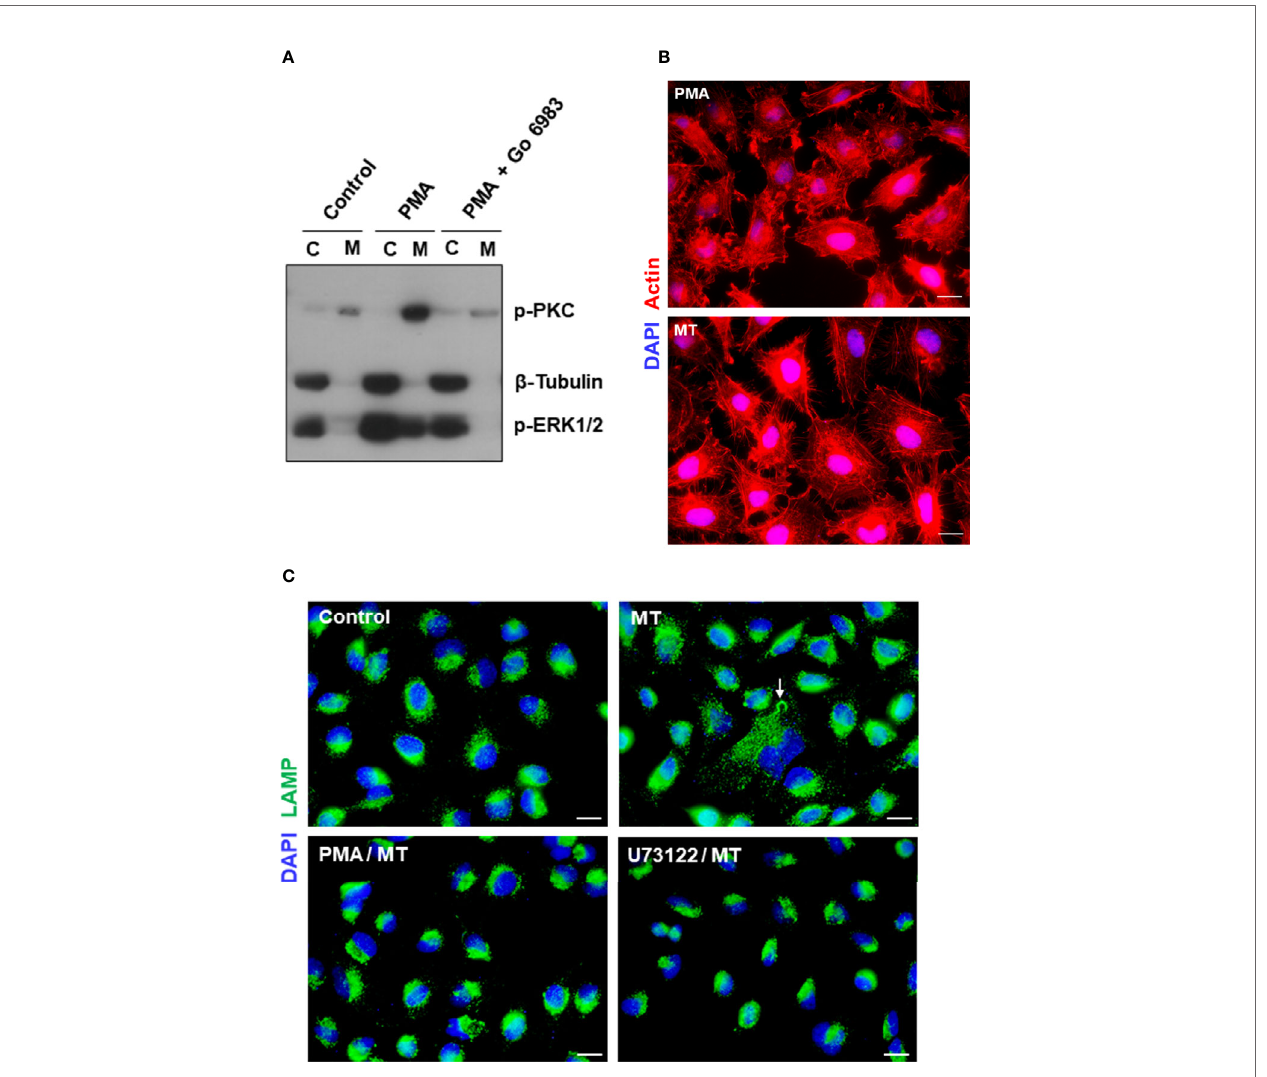
FIGURE 8 | Effect of PKC activator PMA on cytoskeleton disruption and MT-induced lysosome mobilization. (A) HeLa cells were untreated or treated with PMA, in absence or in the presence of PKC inhibitor Go 6983, and the membrane (M) and cytosolic (C) fractions were analyzed for detection of phoshorylation levels of PKC and ERK1/2. (B) HeLa cells, untreated or treated with PMA, were incubated with MT for 30 min and processed for immuno fl uorescence microscopy to visualize actin cytoskeleton (red) and nucleus (blue). Scale bar = 10 µm. (C) HeLa cells, untreated or treated with PMA or PLC inhibitor U73122, were incubated with MT for 30 min and processed for immuno fl uorescence microscopy to visualize lysosomes (green). In untreated cells that interacted with MT, lysosome spreading induced by the parasite (white arrow) can be seen. Scale bar = 10